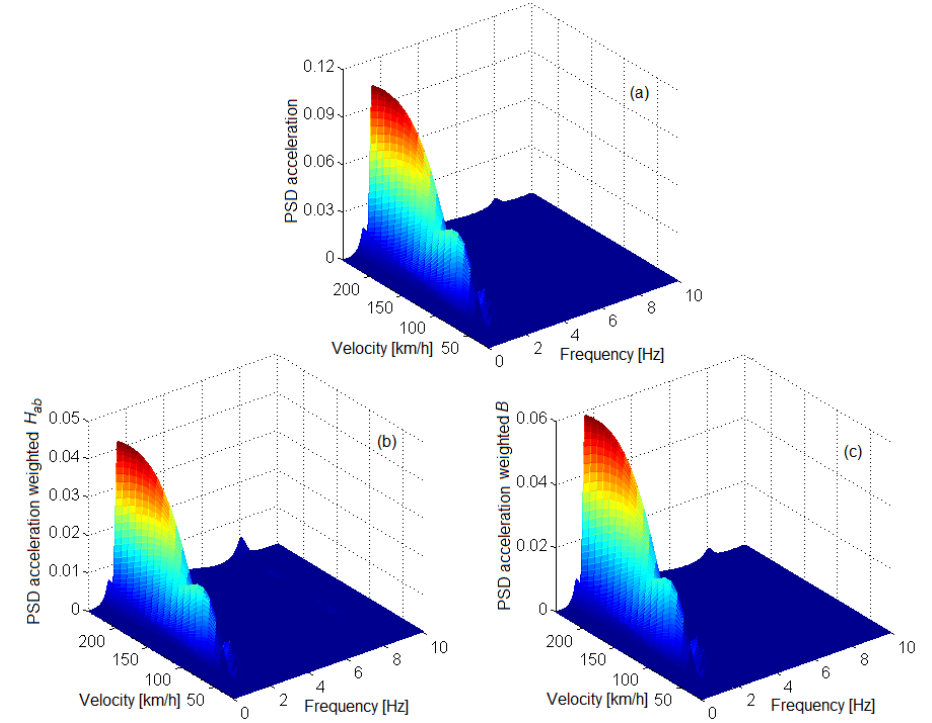
Figure 7. Correlation between ride comfort index N MV and ride comfort index W z .Power spectral density of acceleration (PSD acceleration) in reference point B 1 in (m/s 2 ) 2 /Hz: ( a ) unweighted; ( b ) weighted with weighting function H ab ; ( c ) weighted with weighting function B.